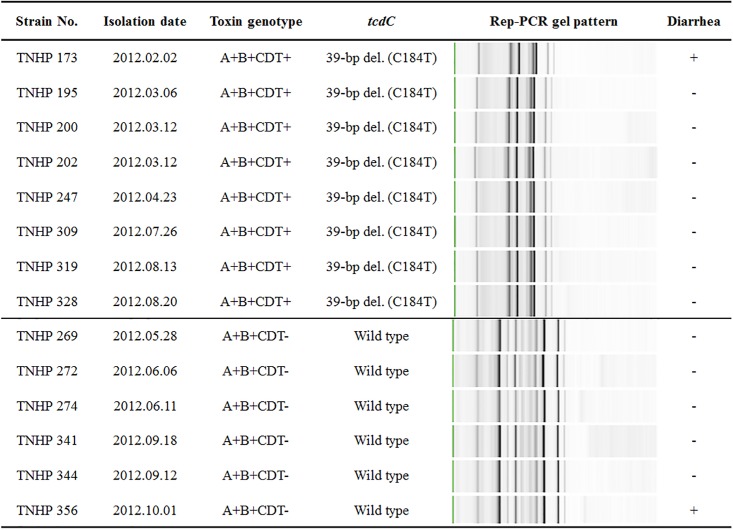
Molecular characteristics of consecutive fecal isolates of Clostridium difficile obtained from two patients, TNHP 173~TNHP 328 (ribotype 126) and TNHP 269~ TNHP 356 (ribotype 106), respectively.A = tcdA; B = tcdB; CDT = binary toxin; bp = base-pair; del. = deletion; Rep-PCR = repetitive sequence-based polymerase chain reaction.